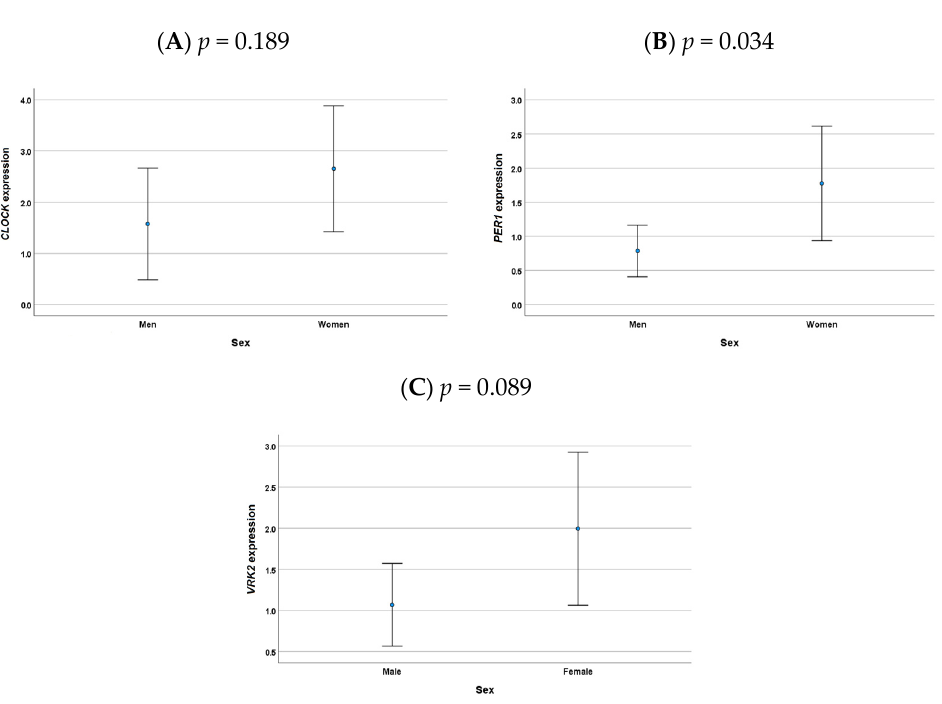
Figure 1. Representation of the clock gene expression by sex. ( A ) Differences in CLOCK genes between males and females were not statistical significance ( p = 0.189). ( B ) Females showed higher PER1 gene expression than men ( p = 0.034). ( C ) A trend was observed for a higher VRK2 gene expression in females than in males ( p = 0.089).